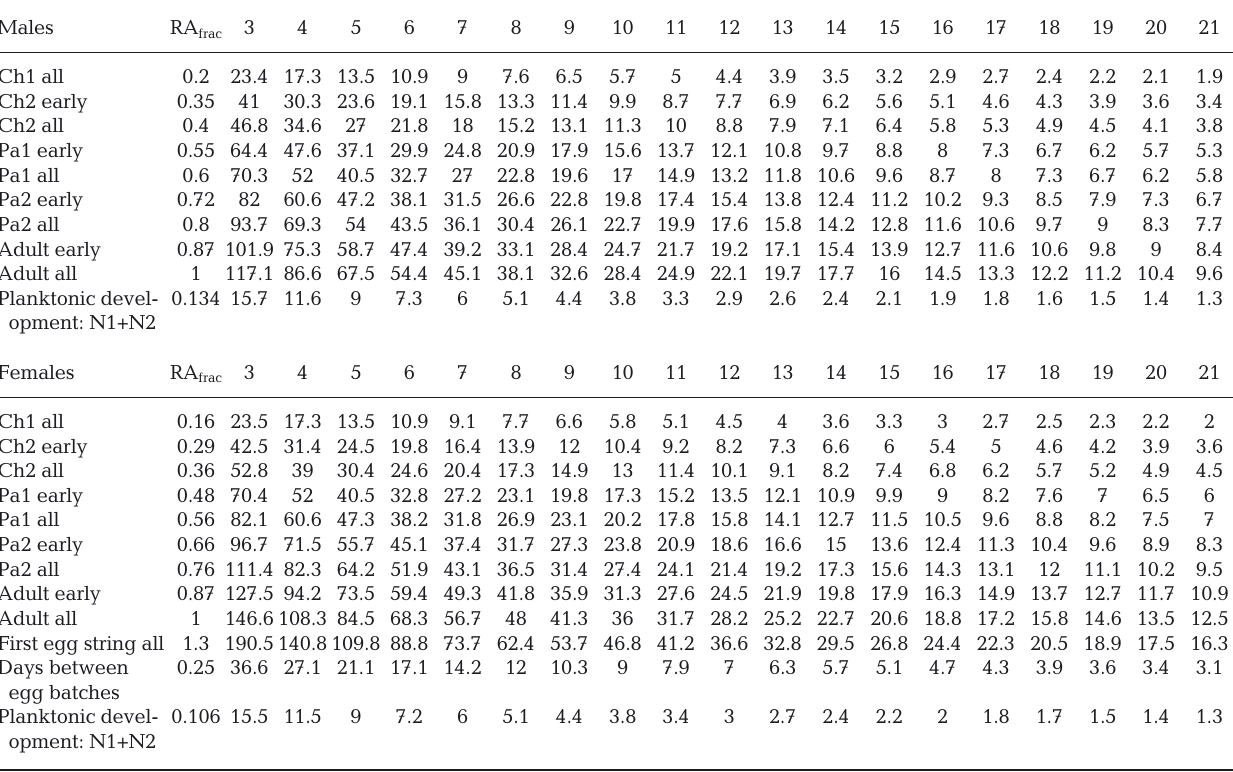
Table 4. The Lepeophtheirus salmonis pattern of development described in terms of relative age (RA frac ) and the timing of develop- ment events in terms of dpi at temperatures from 3 to 21°C. The table shows when the fastest developers start molting to the next stage (early) and when the majority of males and females reach a certain stage (all). The growth model estimates the number of days until the majority of the population has become adult (DTA) at each temperature using the term 5/rM( T ), and the timing of develop- mental events in terms of dpi is calculated by RA frac × DTA. The timing of extrusion of first egg string in terms of relative age is based on data from this study and L. A. Hamre (unpubl. data). Development from hatching to copepodid was translated to relative age based on data from the literature. The rationale behind this estimate is given in Section